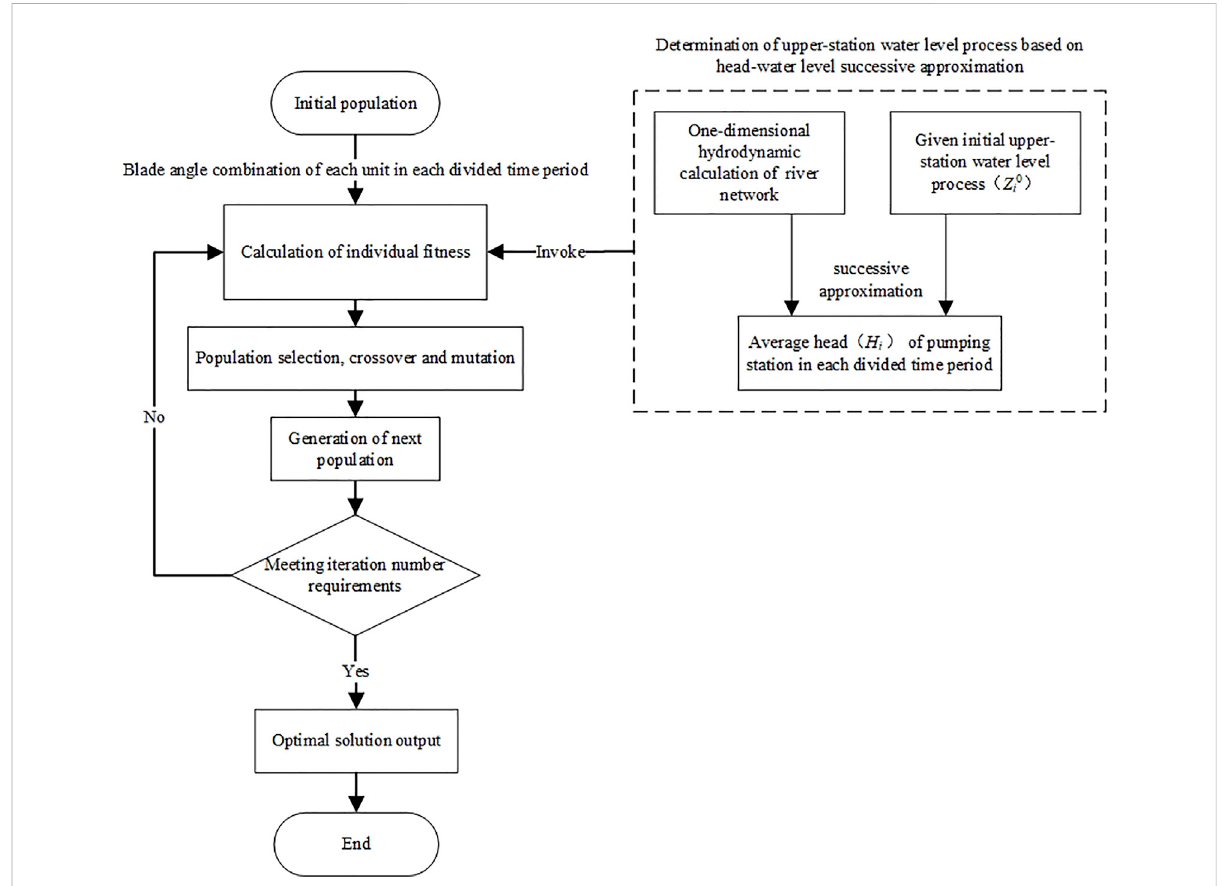
FIGURE 1 Algorithm fl ow chart of genetic algorithm coupled with head-water level successive